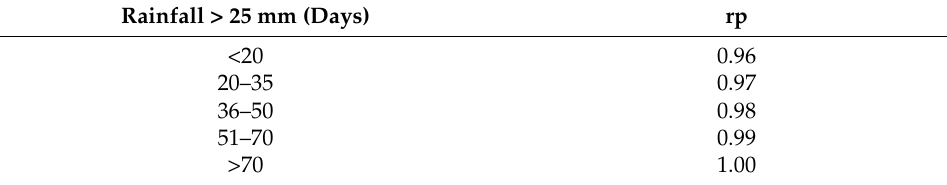
Table 25. Rainfall parameter rp.